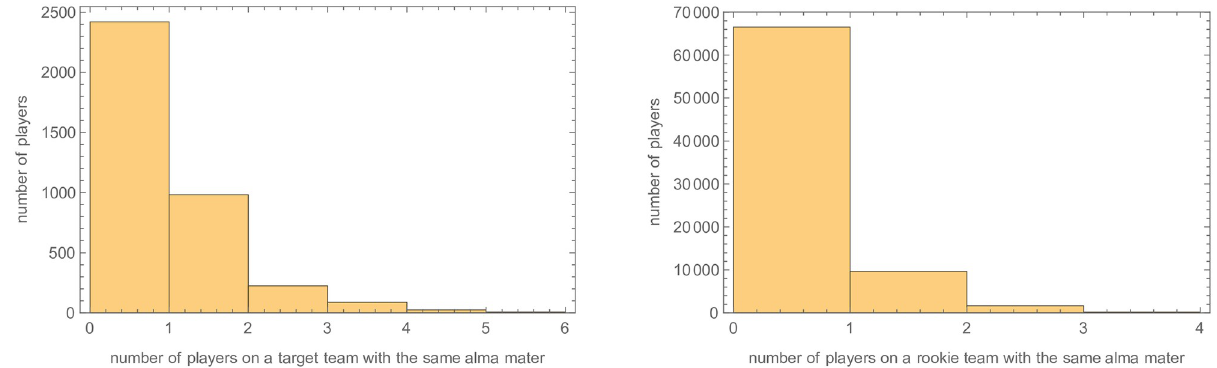
Fig 4. Left: A histogram of the number of players on the target team of a switching player who attended that player’s alma mater. Right: A histogram of the number of players on a rookie’s team who attended the same alma mater.